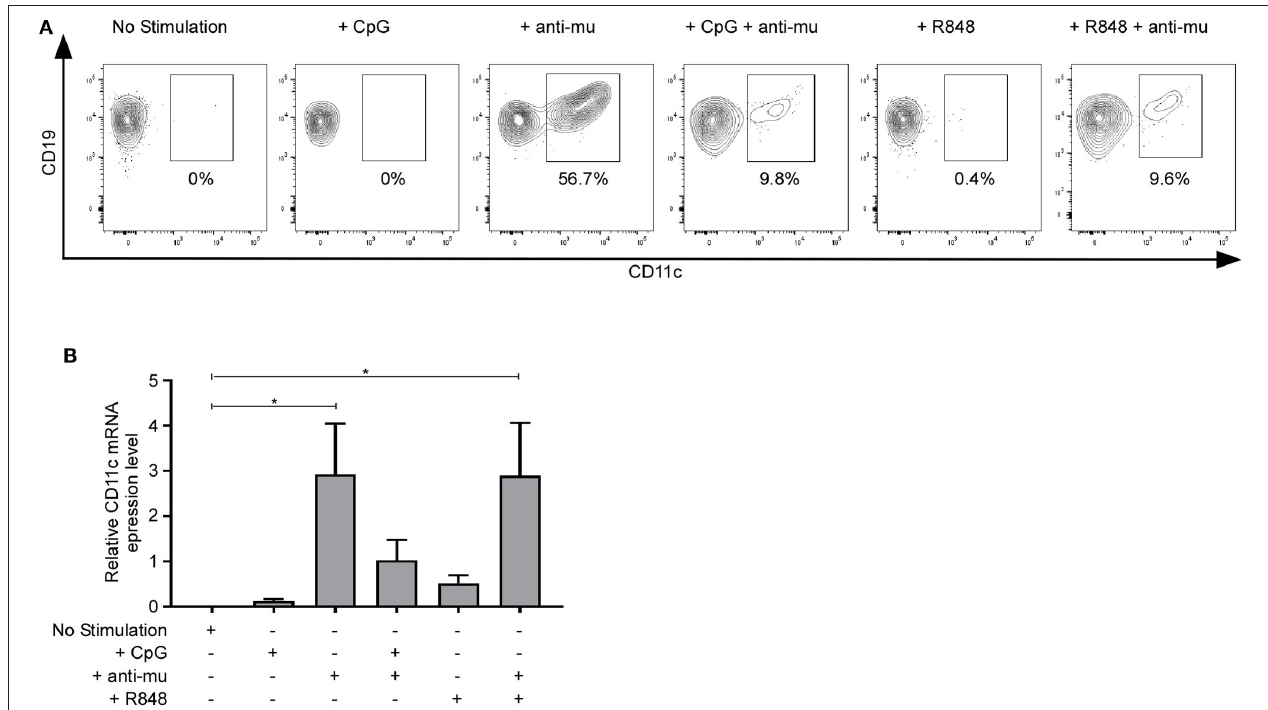
FIGURE 7 | Upregulation of CD11c upon B-cell receptor (BCR) stimulation. CD11c expression was measured after defined stimulation on purified CD11c − B cells by (A) flow cytometry (one representative result of three independent experiments is presented) or (B) by qPCR ( n = 4). Bar graphs show mean ± SEM of relative CD11c expression. Means were compared using one-way analysis of variance followed by Dunnett post hoc test: * p < 0.05.